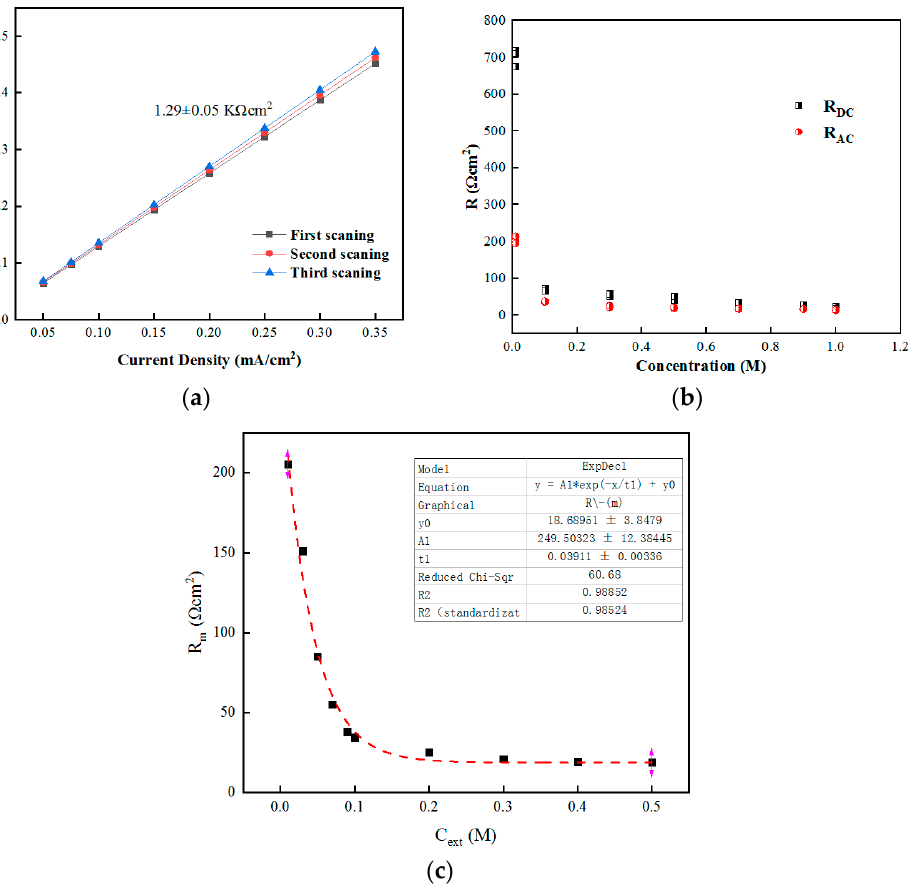
Figure 8. ( a ) Membrane impedance at different NaCl concentrations on either side of the membrane: 0.01 M and 1 M, respectively; ( b ) membrane impedance measured by DC and AC methods at the same concentration on both sides of the membrane. ( c ) Correlation analysis between the experimental membrane impedance and model-calculated membrane impedance.